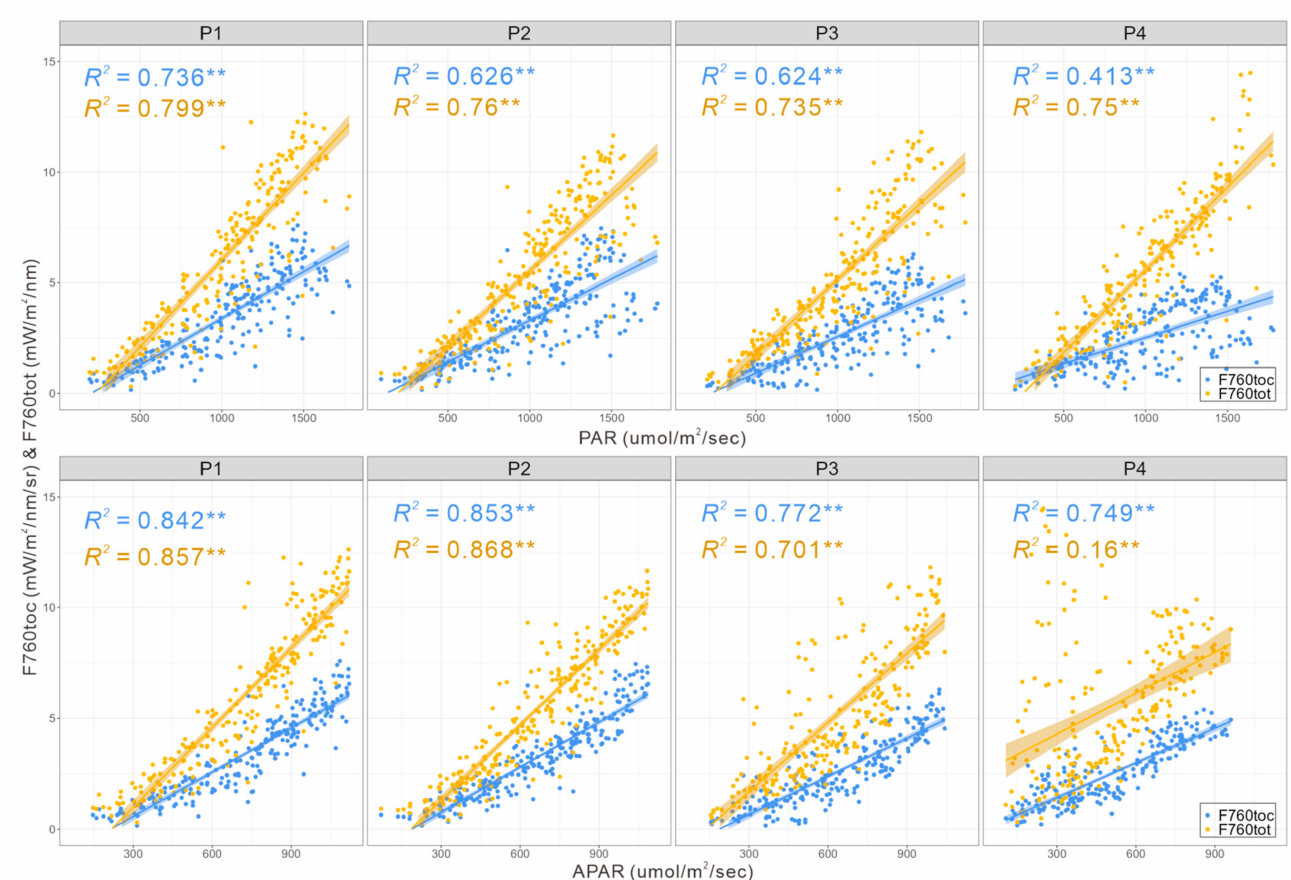
Figure 7. Relationship between hourly PAR, APAR, and F760toc (blue) or F760tot (golden) in the field campaign collected from four plots (P1–P4). The blue or golden lines with band denote the regression line and 95% confidence interval, respectively. Significance was performed according to two-tailed test (ns: p > 0.05. * p < 0.05. ** p < 0.01. *** p <